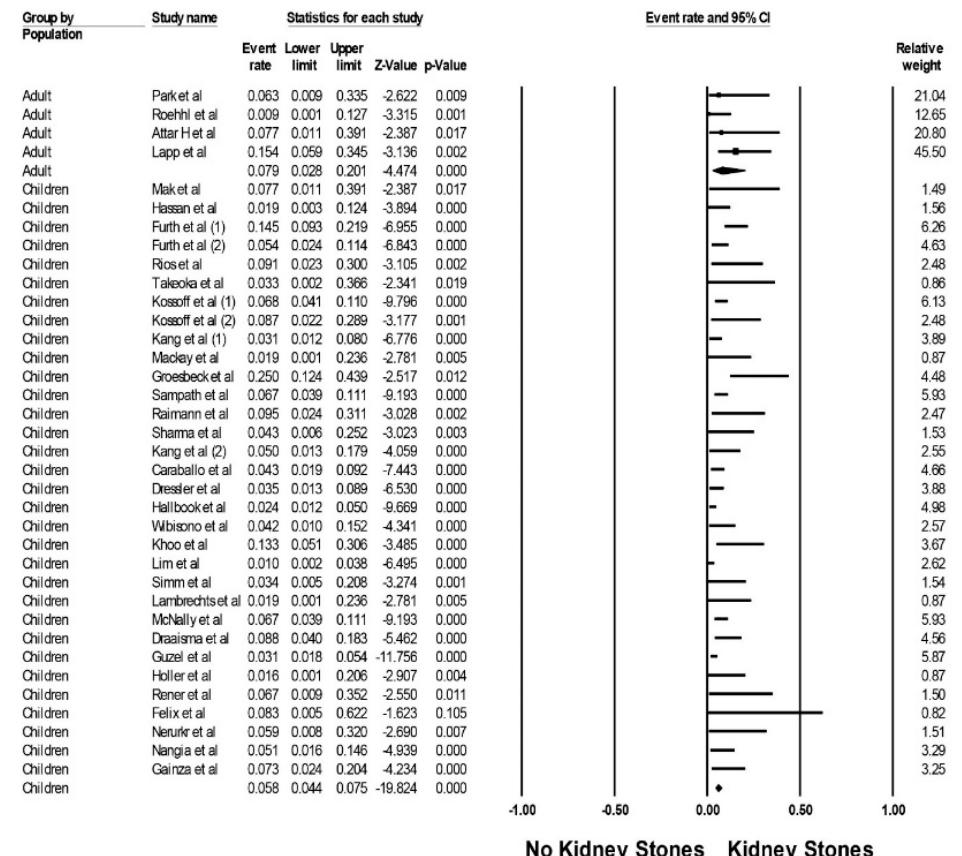
Figure 3. Pooled estimated incidence of kidney stones by patient population.